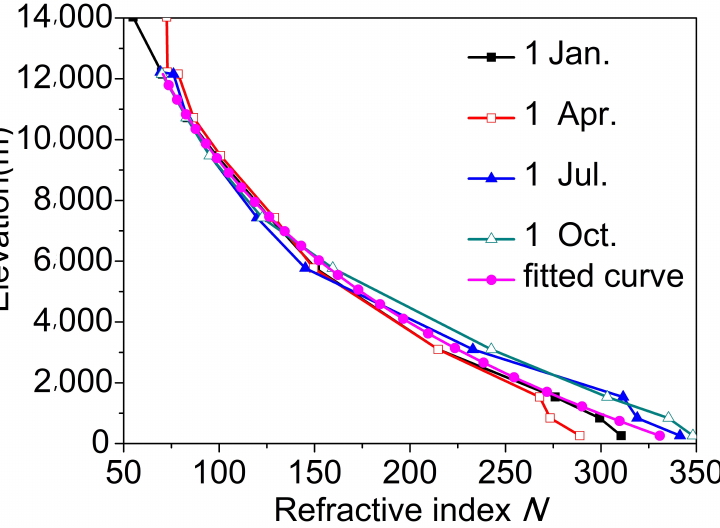
Figure 1. The tropospheric refractivity of Chongqing for different seasons and the fitted